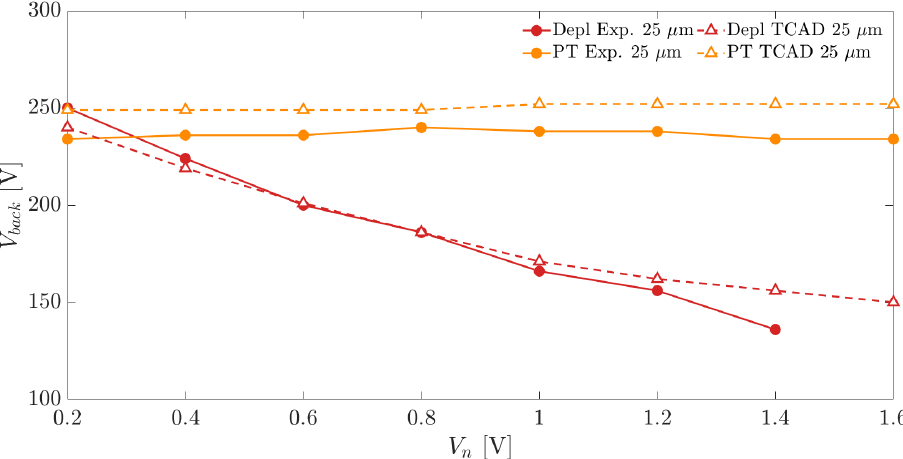
Figure 16. Depletion and punch-through voltages as a function of the applied frontside bias V n for a substrate thickness of 300 µ